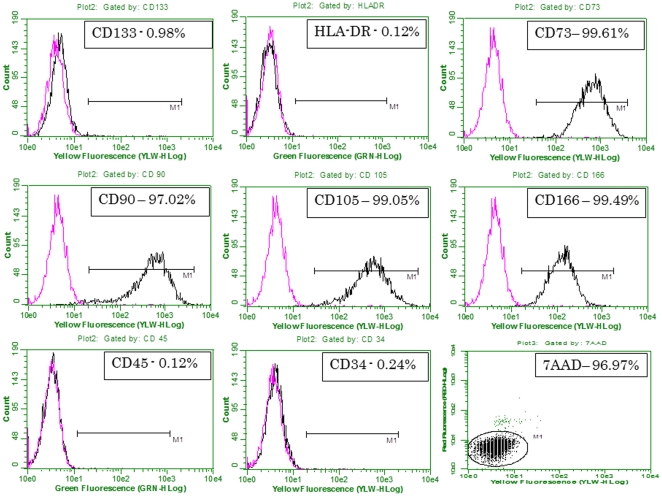
Flow cytometer CD Marker Expression for control hMSC (without Ag NPs).